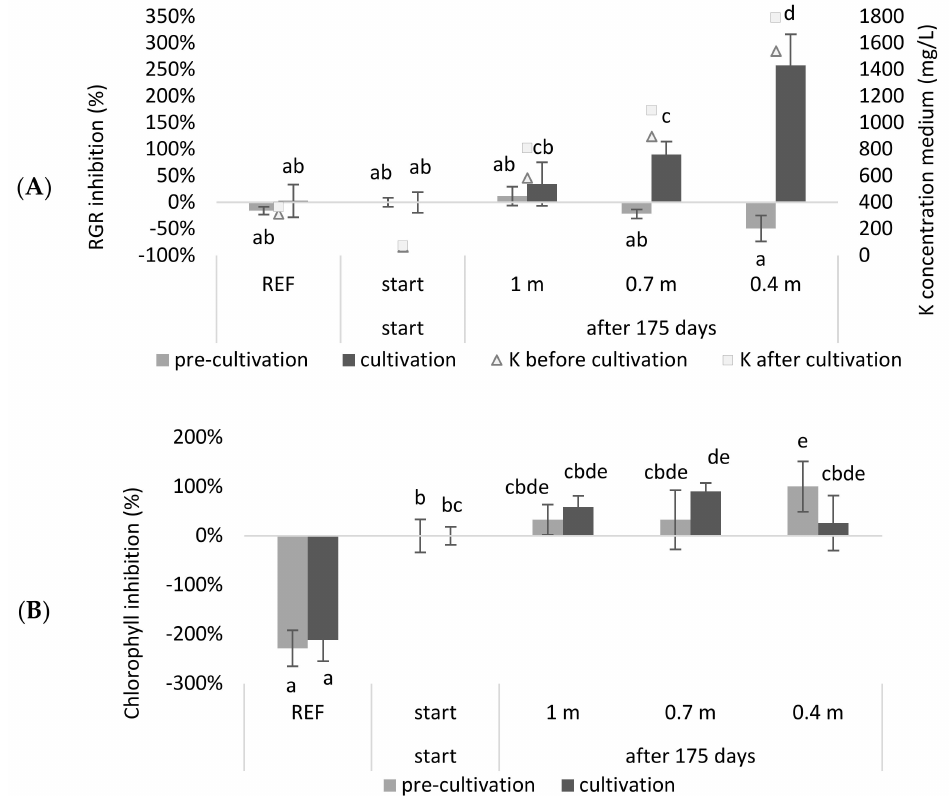
Figure 2. The relative growth rate inhibition ( A ), and the chlorophyll inhibition ( B ) of duckweed cultivated on a simulation of the concentration of wastewater of a continuous system, before and after 175 growing days, with different buffering capacities. Significant differences (n = 4 and p < 0.05) per graph are indicated by different letters. Error bars indicate standard